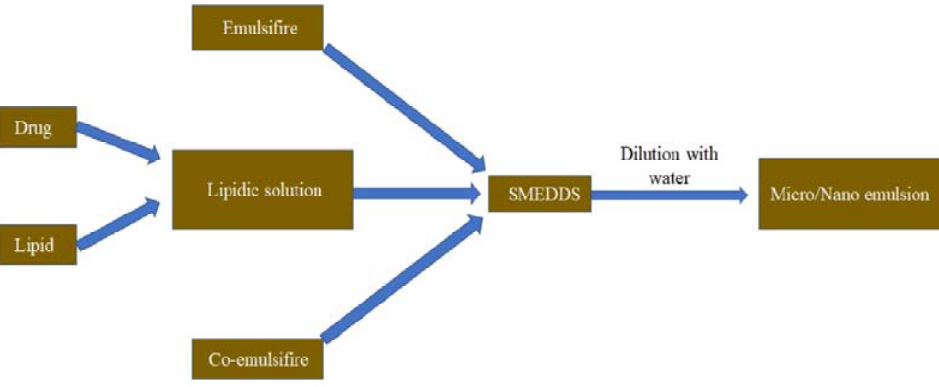
Fig.3. The general technique of preparation a self-micro-emulsifying drug delivery system and their resulting form to micro emulsion